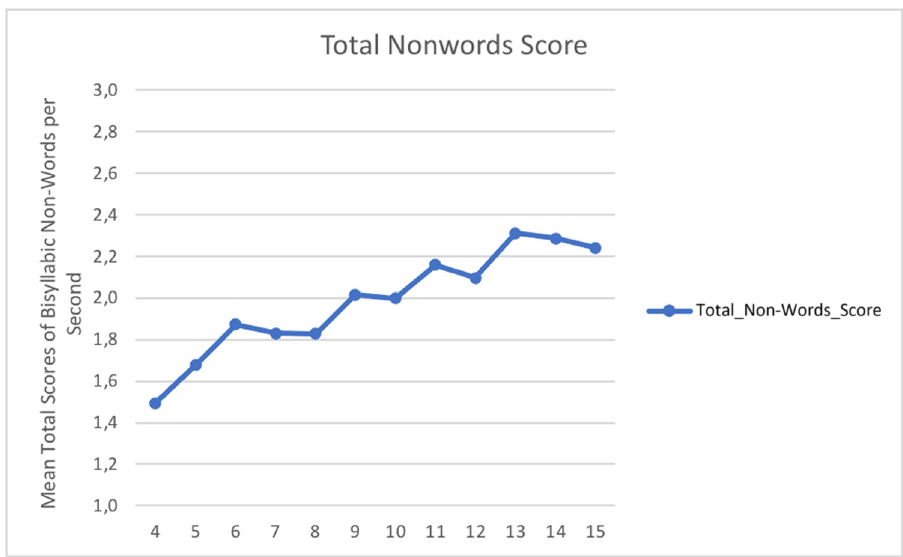
Figure 3: Total scores of non - word stimuli repetition per second by age.